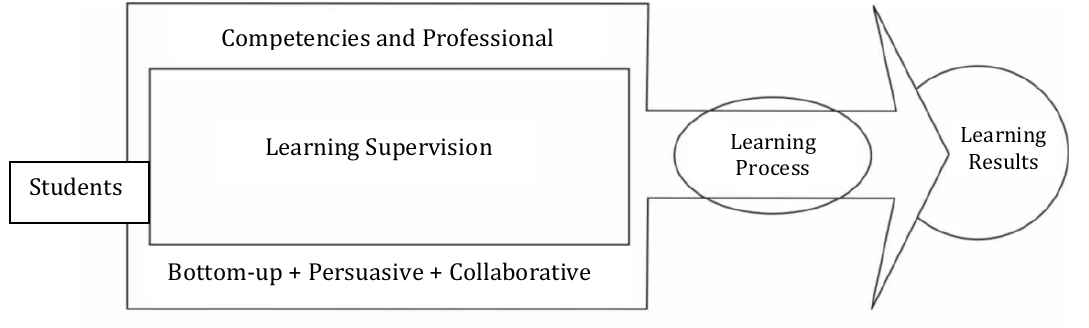
Fig. 1 Design Chart of Academic Supervision